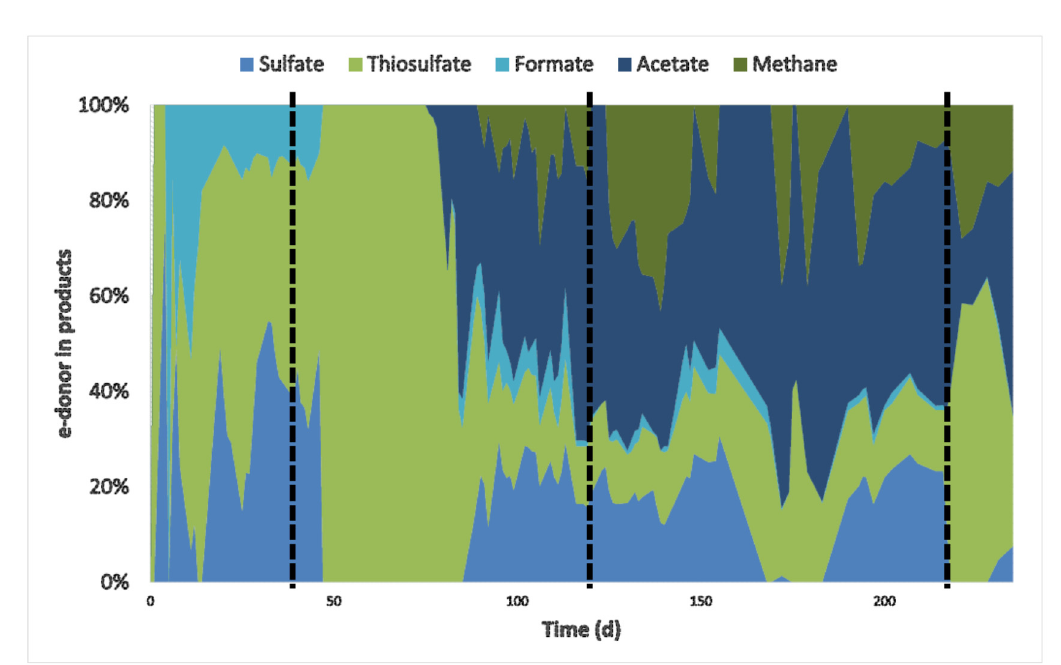
Figure 3. Fraction of electron donor (H 2 + CO) used by the different metabolisms: sulfate and thiosulfate reduction and formate, acetate and methane production. For calculation, all values of electron donors and acceptors were converted to mmol/d. Vertical dashed lines represent the beginning of CO experiments: 5% CO (1st), 15% CO (2nd), and 60% CO spike (3rd).